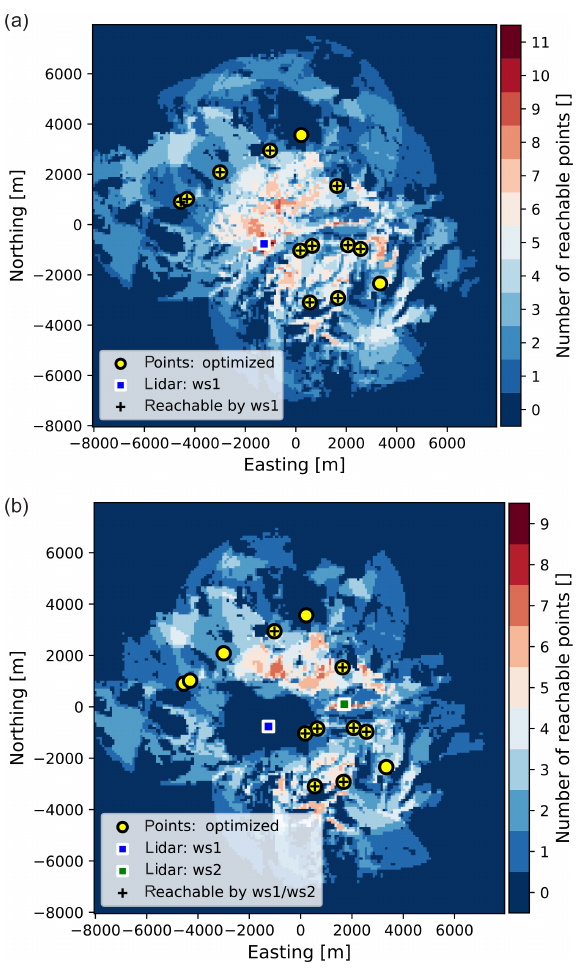
Figure 11. Placing lidars at Italian site: (a) locating first lidar at the combined layer; (b) locating second lidar at the second lidar placement layer.